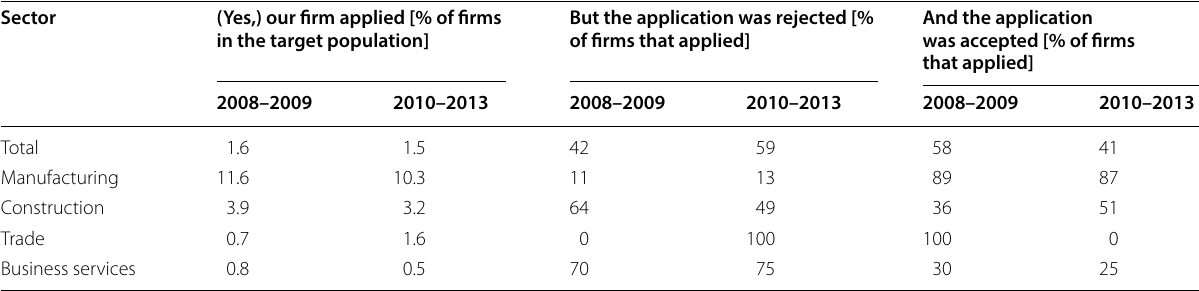
Weighted to be representative of the firm population. Financial intermediation is not shown in the table as all figures are